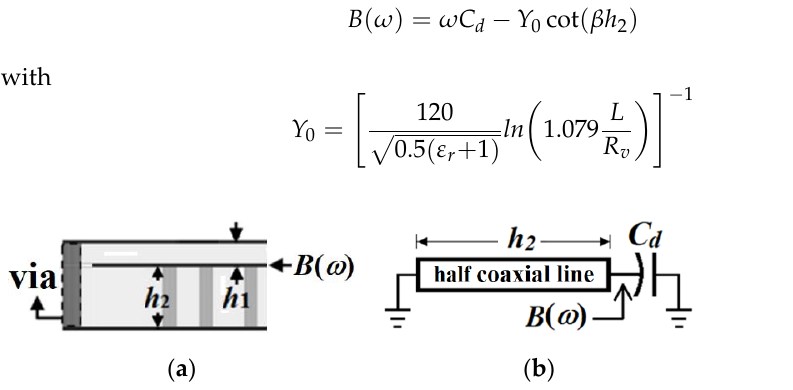
Figure 6. ( a ) The side view of the HMSICR; and ( b ) the equivalent transmission-line model for the susceptance looking into the embedded semicircular patch.